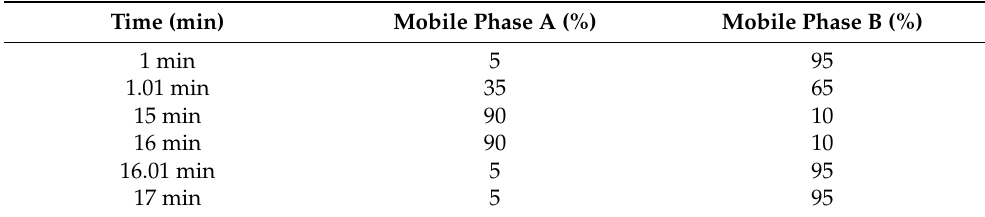
Table 3. Gradient elution conditions for HPLC